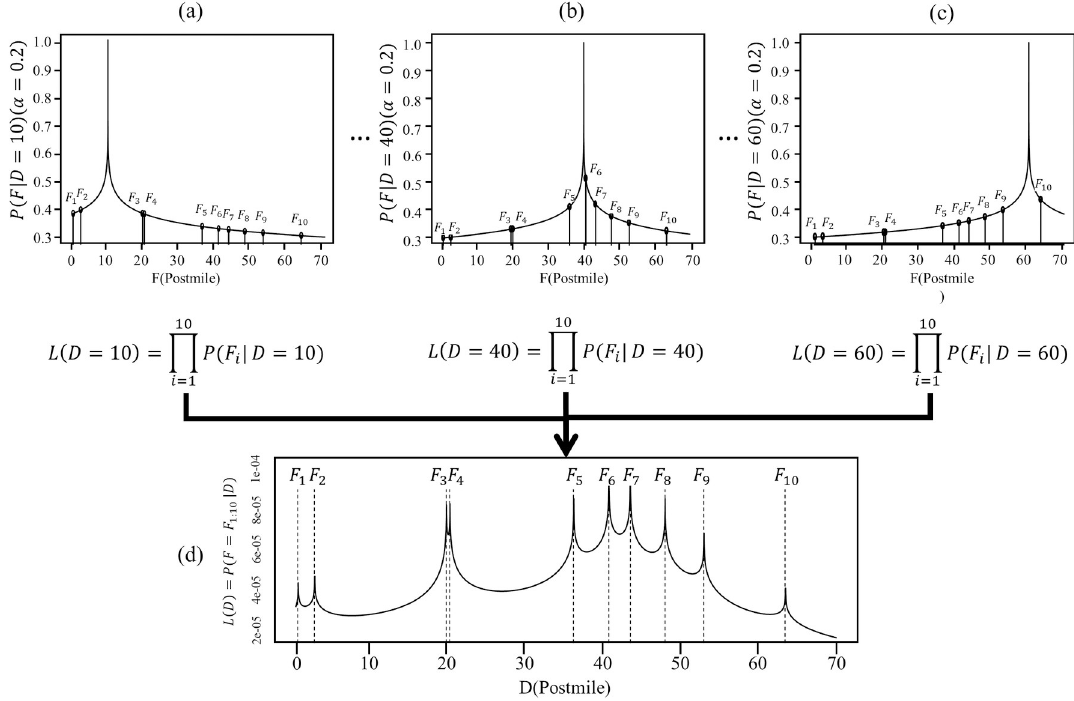
Fig 3. Procedure for estimating the likelihood of fatal collisions occurring at locations F 1 to F 10 given R at D on I-80W in 2006. (a), (b), and (c) Individual likelihoods of fatal collisions at D = 10, D = 40, and D = 60, respectively. (d) Combined likelihood of all fatal collisions with D increasing by 0.01 mile increments along entire